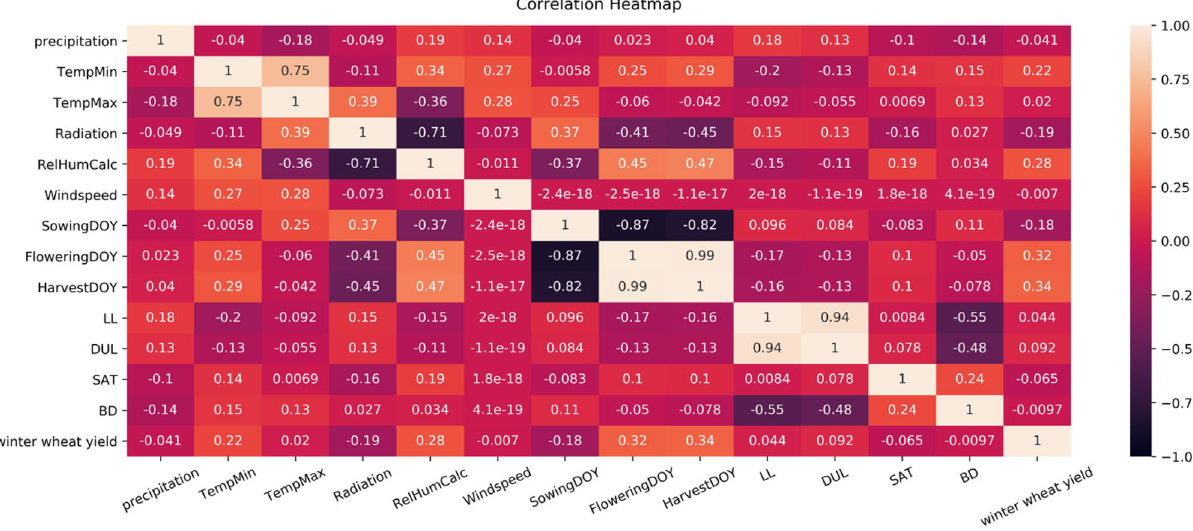
Figure 1. Pearson correlation heatmap of weather, phenology, soil, and yield data; darker colors show high correlation (close to 1), and lighter colors show low correlation (close to 0).